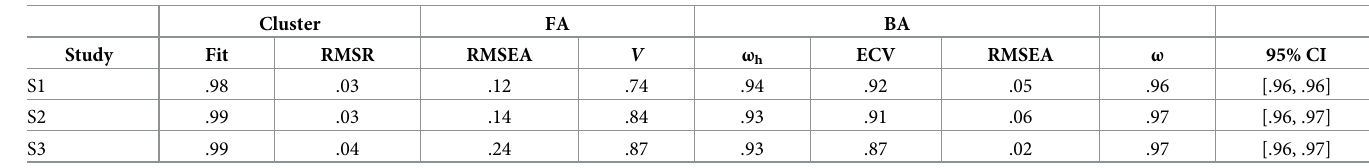
Table 4. Suicidality Scale model